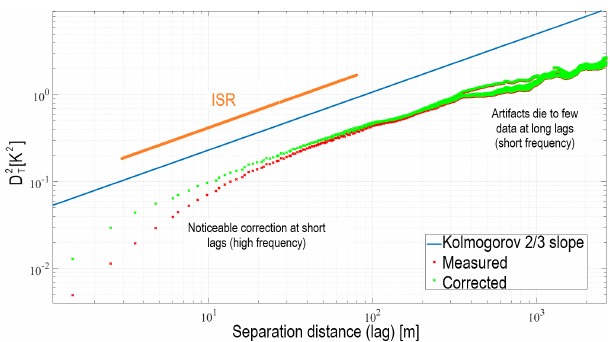
Figure 10. Structure function of the simulated weather signal in CBL conditions and processed signals using the sensor models. Re- sults from before and after applying the IDMP are illustrated.